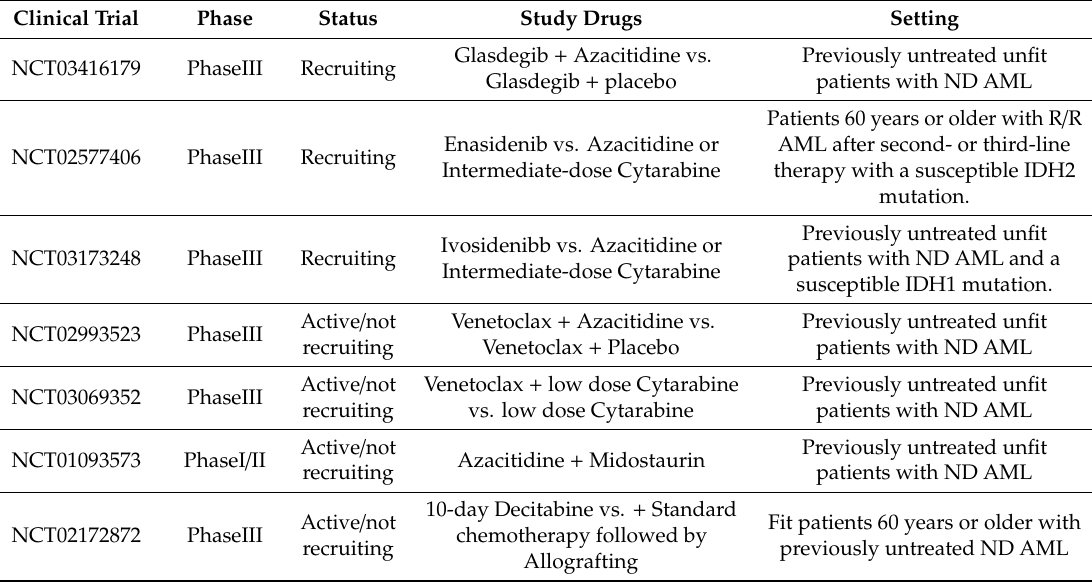
Table 3. Ongoing clinical trials for older / unfit patients with AML. Clinical